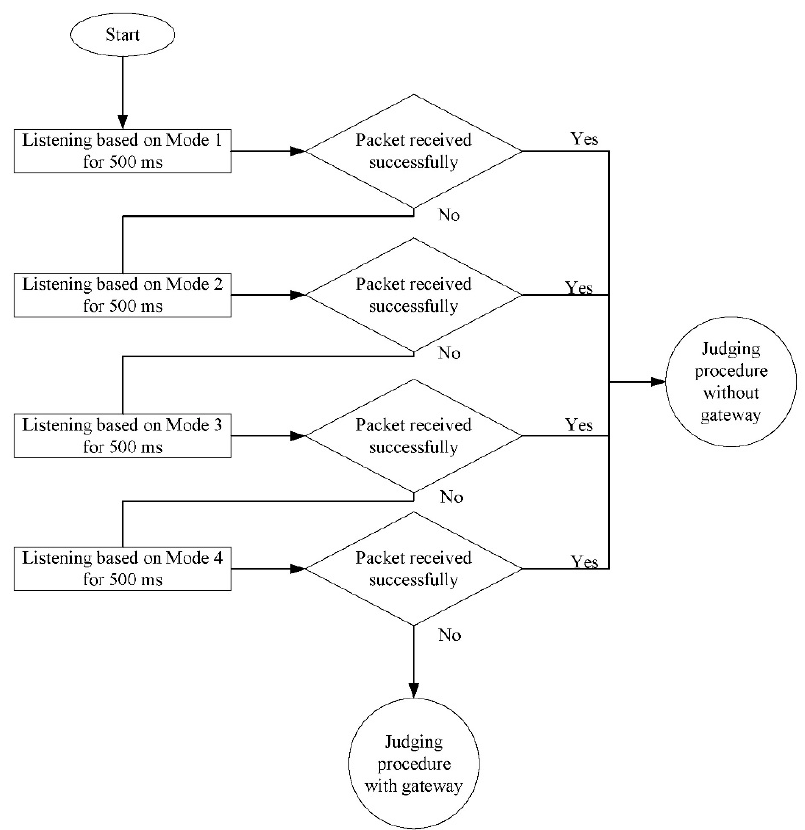
Figure 3. Communication protocol identification procedure.